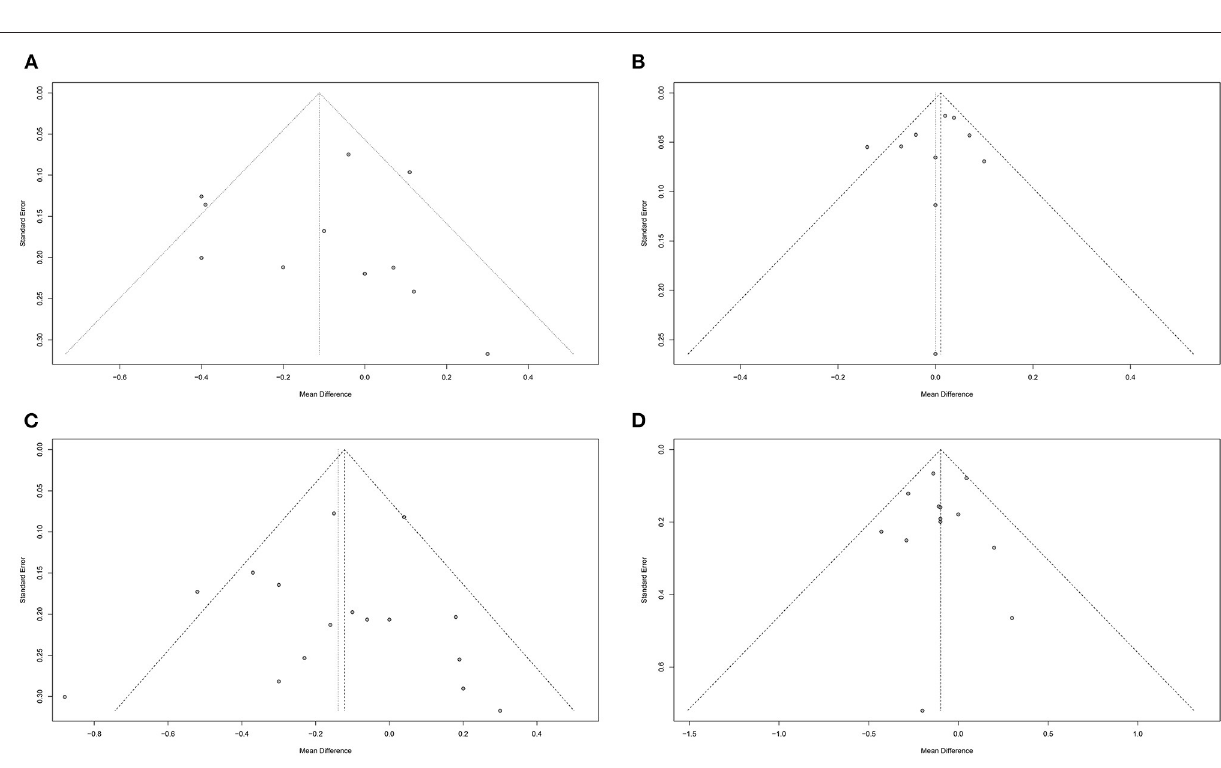
Frontiers in Nutrition |